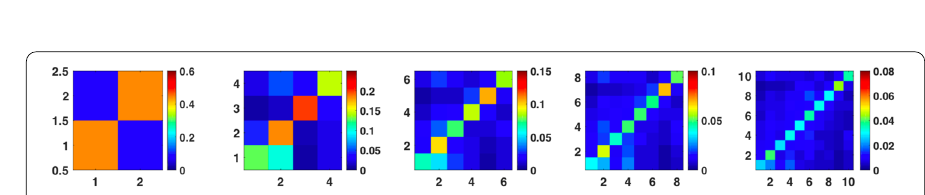
Figure 16 Mixing matrices of Twitter mention networks for extreme neighborhoods in terms of median household income for the Northern American metropolitan area. The columns from left to right correspond to the consideration of 1, 2, 3, 4 and 5 extreme groups on both the low and high socio-economic distribution